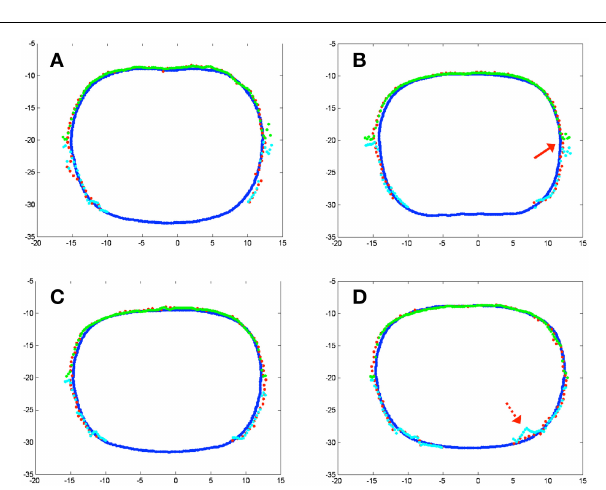
FIGURE 8 | 2D contour results on phantom at different depth according to Figure 5. (A) z = − 25 . 3cm; (B) z = − 31 . 3cm; (C) z = − 37 . 3cm; (D) z = − 43 . 3cm.BluelinesrepresentcontourbyCTimages,reddotsrepresent reconstructedcontourbythenovelsurfacecontourreconstructionalgorithm, while green and cyan lines represent different parts of the reconstructed surface contour by conventional 3D interpolation